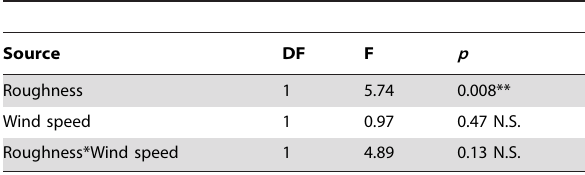
Table 3. Effects of beach surface properties and wind speed on distance traveled by C. dorsalis media larvae.